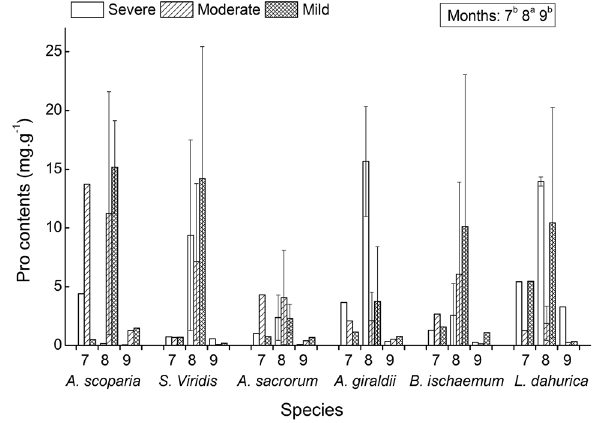
Figure 4. Proline contents of six successional seral species. The proline contents were measured on July (7), August (8) and September (9) under three water deficient levels (severe, moderate and mild). Significant multi-comparison results of month were marked as a legend within a block (see associated ANOVAs results of Table 1).